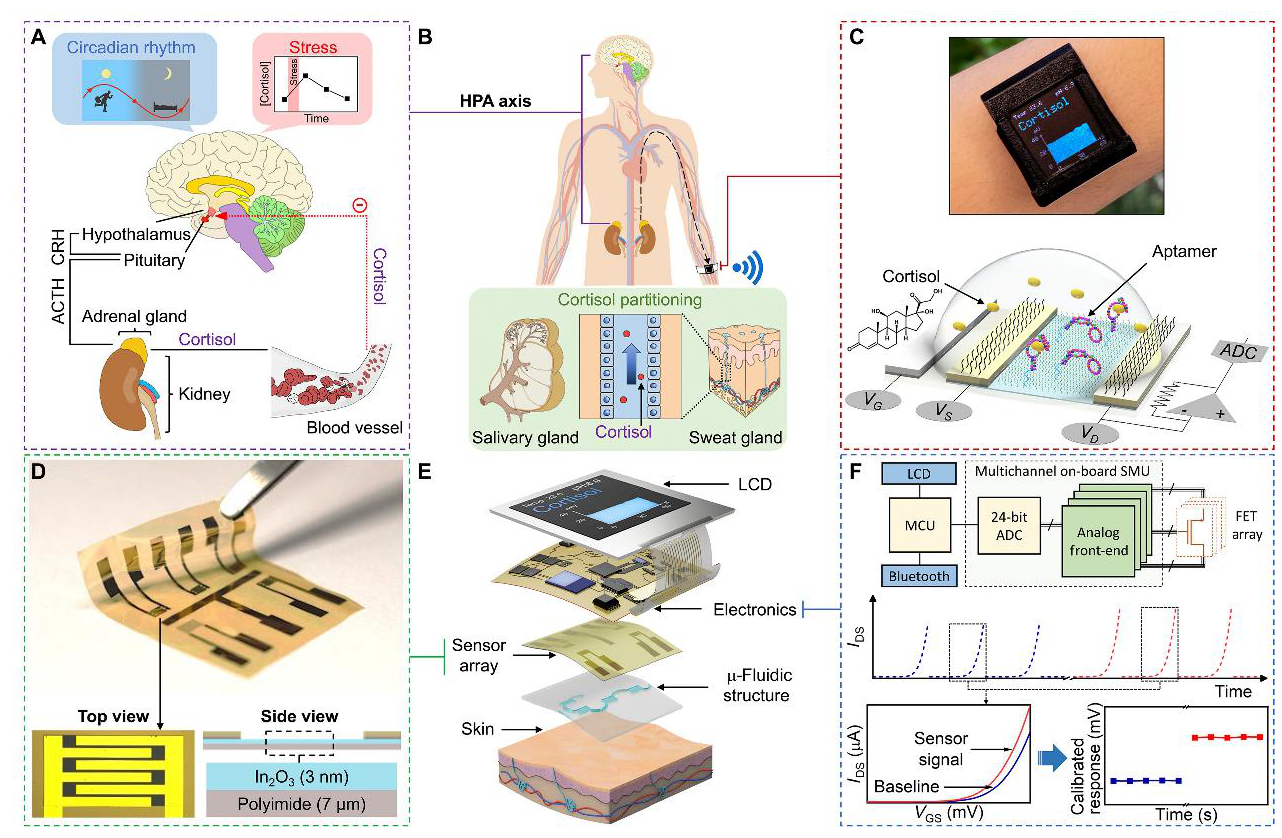
Figure 3. Wearable aptamer field effect transistor (FET) sensor for cortisol monitoring in sweat. ( A ). The control of level of cortisol in response to stress and circadian rhythm by hypothalamus-pituitary-adrenal axis; ( B ). Salivary and sweat glands excrete a portion of cortisol that is not bound to blood plasma proteins; ( C ). Analysis of saliva and sweat samples by the FET sensor; ( D ). Fabrication of the FET sensor with In 2 O 3 semiconductor channels on a polyimide substrate; ( E ). Depiction of the components of the aptamer FET sensor smartwatch; ( F ). Summary of the FET sensor signal acquisition and data processing via source measurement unit (SMU) and microcontroller unit (MCU), display, and transmission (I DS -source-drain current; V GS -gate voltage) (Reprinted from [95] which